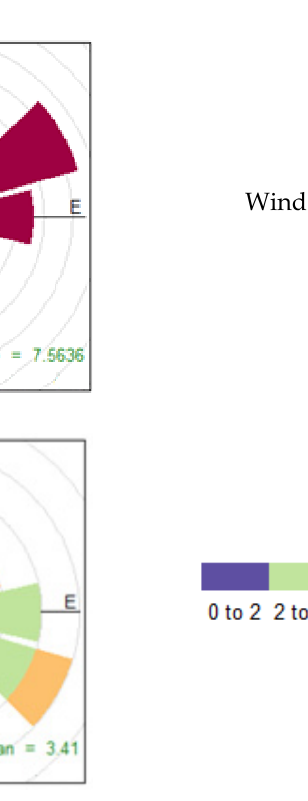
Figure 12. Wind roses for wind-shear cases associated with the four runway corridors: ( a ) 07LA, ( b ) 07RD, ( c ) 07RA, and ( d ) 25RA; percentage of cases shown radially, and colurs indicate wind-speed band (plots generated using the openair package [20] within R software [21]).